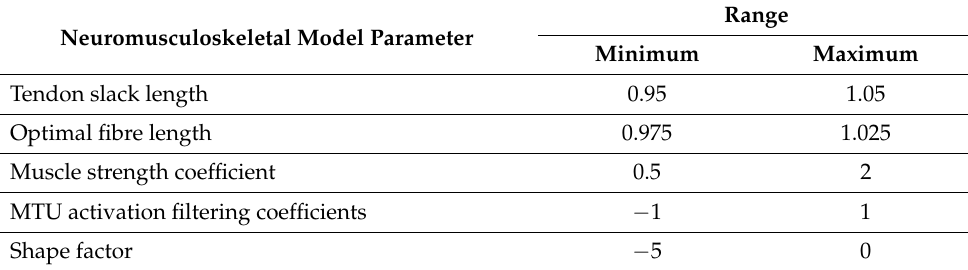
Table 1. Optimising range of parameters for neuromusculoskeletal model.